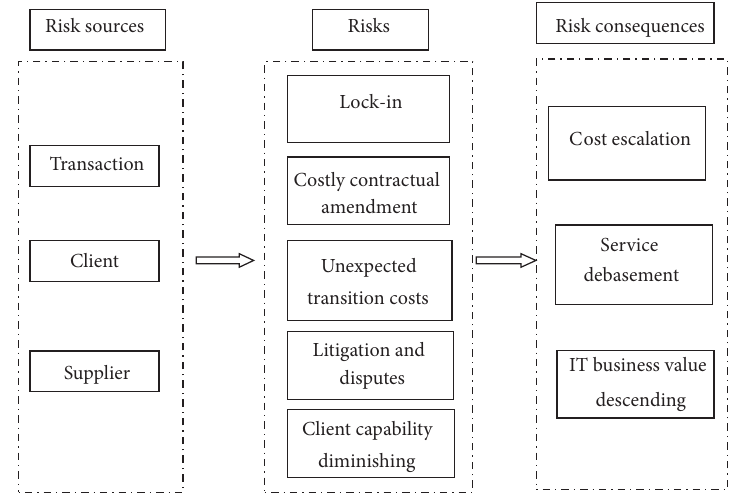
Figure 1: Three layers of IT outsourcing risk